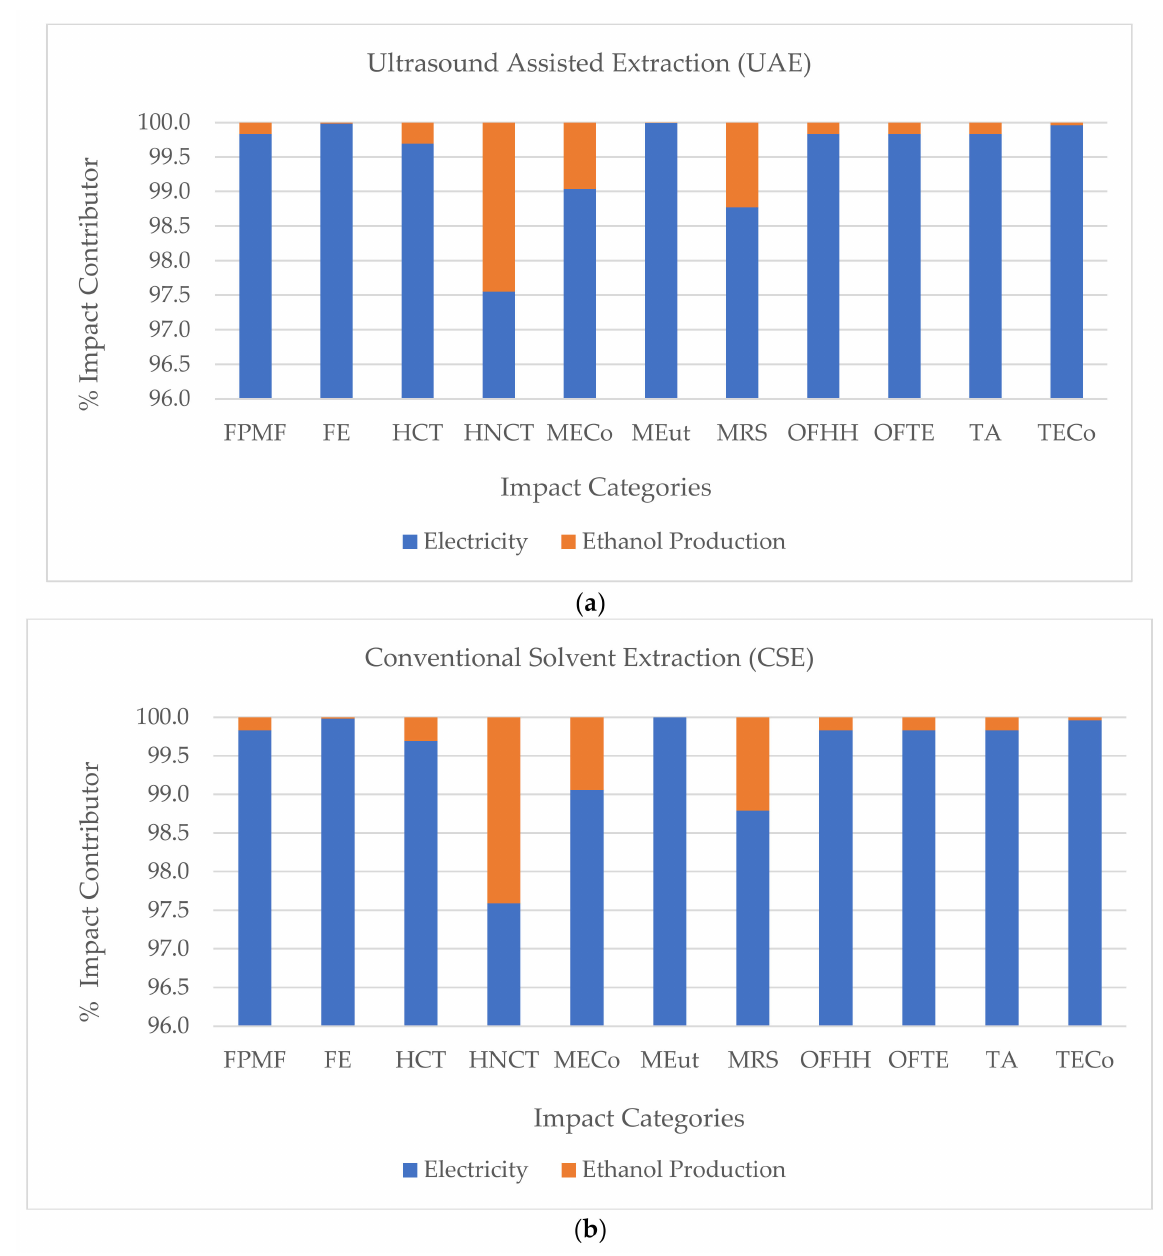
Figure 4. The environmental profile of ( a ) ultrasound-assisted extraction (UAE) and ( b ) conventional solvent extraction (CSE) processes. Abbreviation of impact categories are as follows: FPMF (Fine particulate matter formation), FE (Freshwater ecotoxicity), HCT (Human carcinogenic toxicity), HNCT (Human non-carcinogenic toxicity), MECo (Marine ecotoxicity), MEut (Marine eutrophication), MRS (Mineral resource scarcity), OFHH (Ozone formation, Human health), OFTE (Ozone formation, Terrestrial ecosystems), TA (Terrestrial acidification), and TECo (Terrestrial